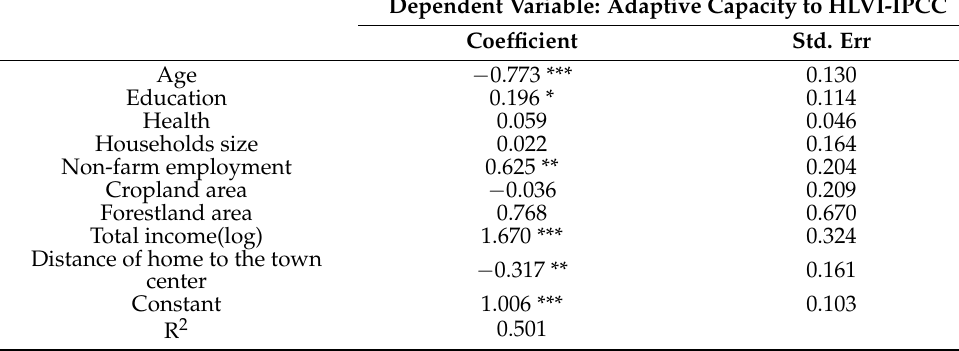
Table 6. Regression results of determinants of